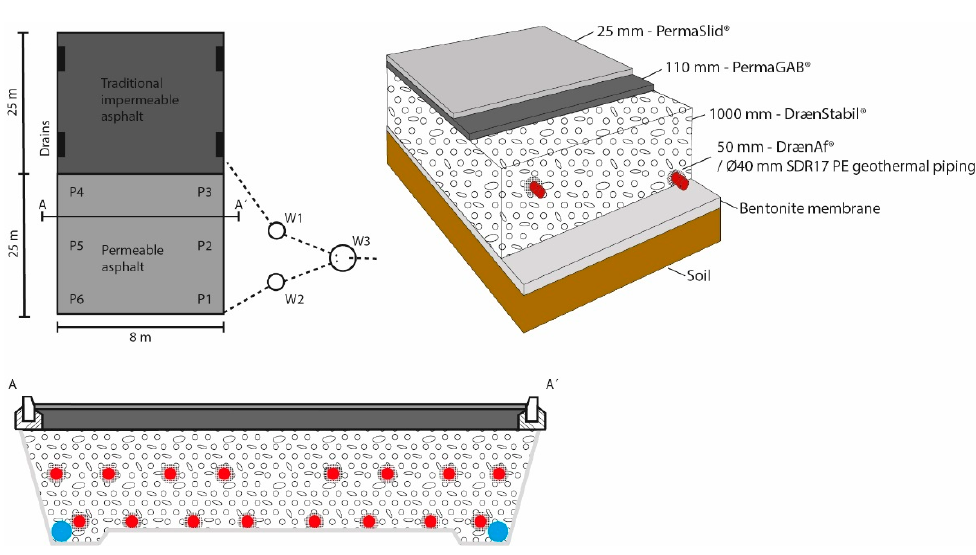
Figure 2. Upper left : 2D overview map. Upper right corner : Composition of the Climate Road. Lower sketch : Cross-section of the Climate Road. The drawing is not to scale.